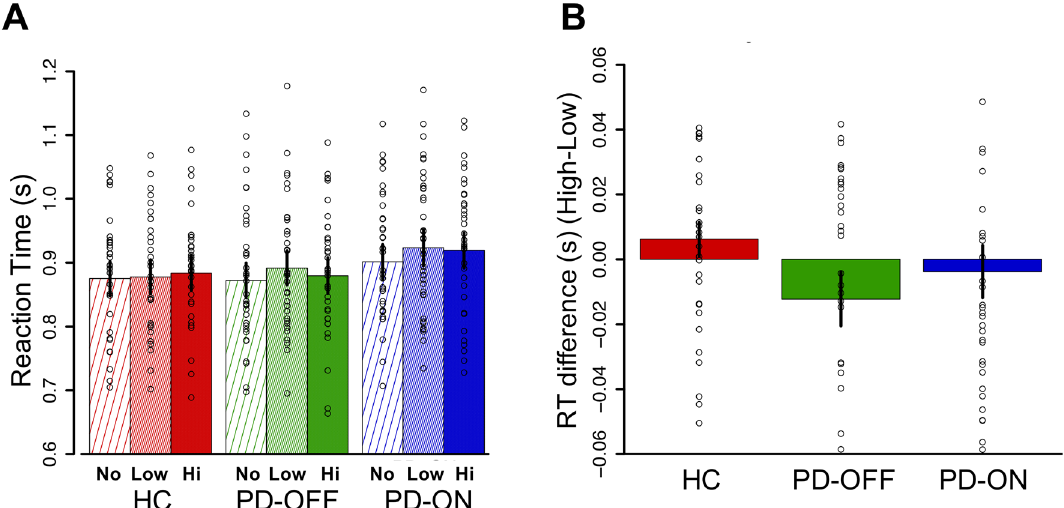
Figure 3. No influence of reward or dopamine on selective attention in Parkinson’s disease. ( A ) Reaction time (in seconds) on the attention task is shown for all three trial types (trials where no distractor was present, trials with a low-reward distractor and trials with a high-reward-associated distractor) for healthy controls and for patients ON and OFF medications. Parkinson’s patients were similarly slowed (i.e., distracted) by the presence of both low and high-reward distractors (low: p < 0.001, high: p = 0.006) and the degree of distraction caused by reward was not influenced by dopamine. ( B ) Difference in reaction time between the high-reward condition and the low-reward condition is shown for healthy controls and for patients ON and OFF medications. Error bars represent standard error of the mean